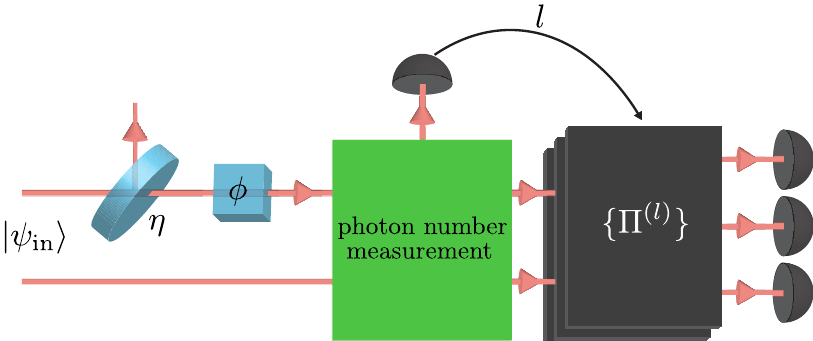
(cid:17) (cid:18) (cid:17) having